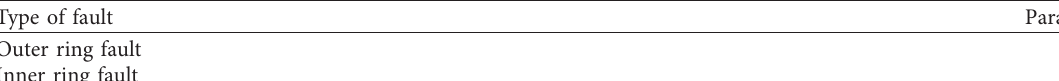
Table 5: Theoretical fault characteristic frequency of bearings.